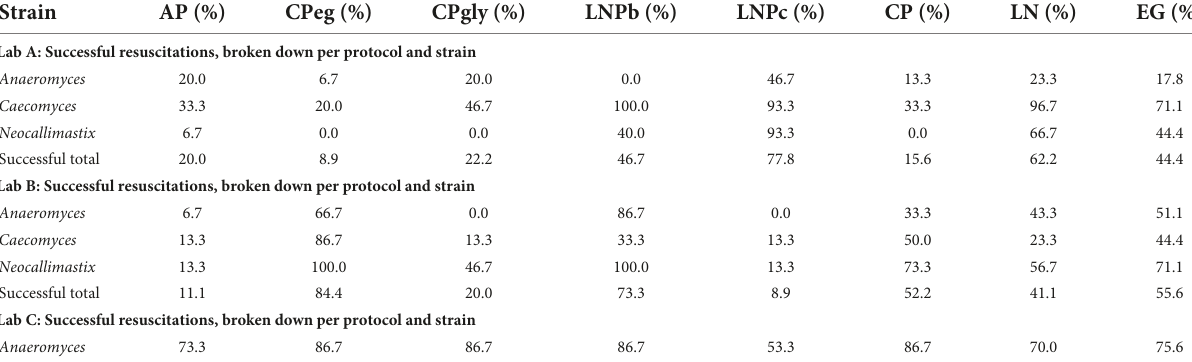
TABLE 3 Survival rates per strain in each